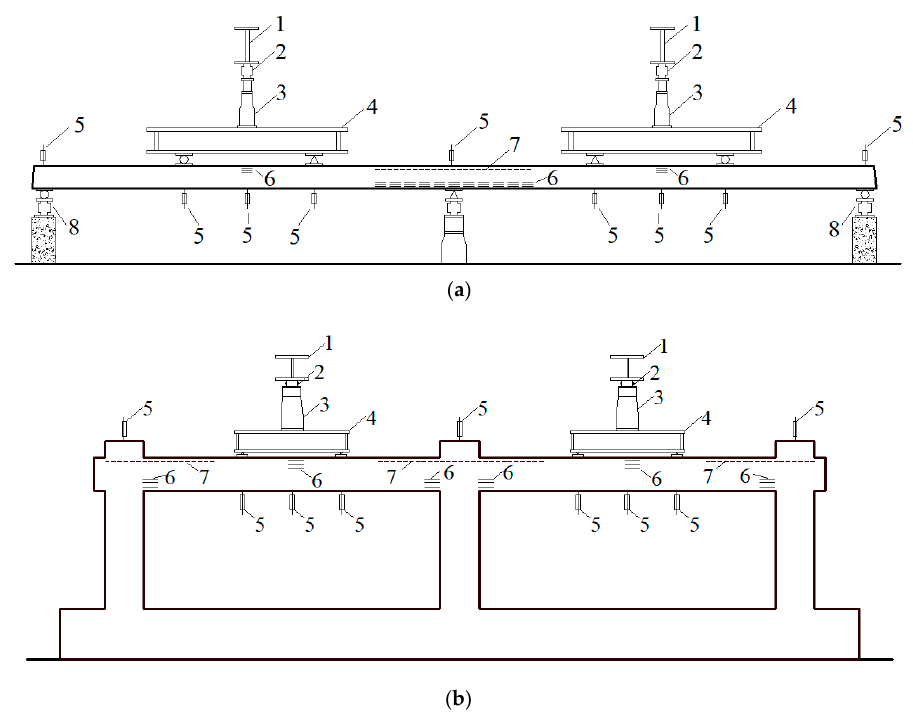
Figure 2. Schematics of the test setups: ( a ) continuous beams; and ( b ) continuous frames. 1, trestle; 2, loading sensor; 3, loading jack; 4, loading distributed beam; 5, displacement transducers; 6, concrete strain gauges; 7, reinforcement strain